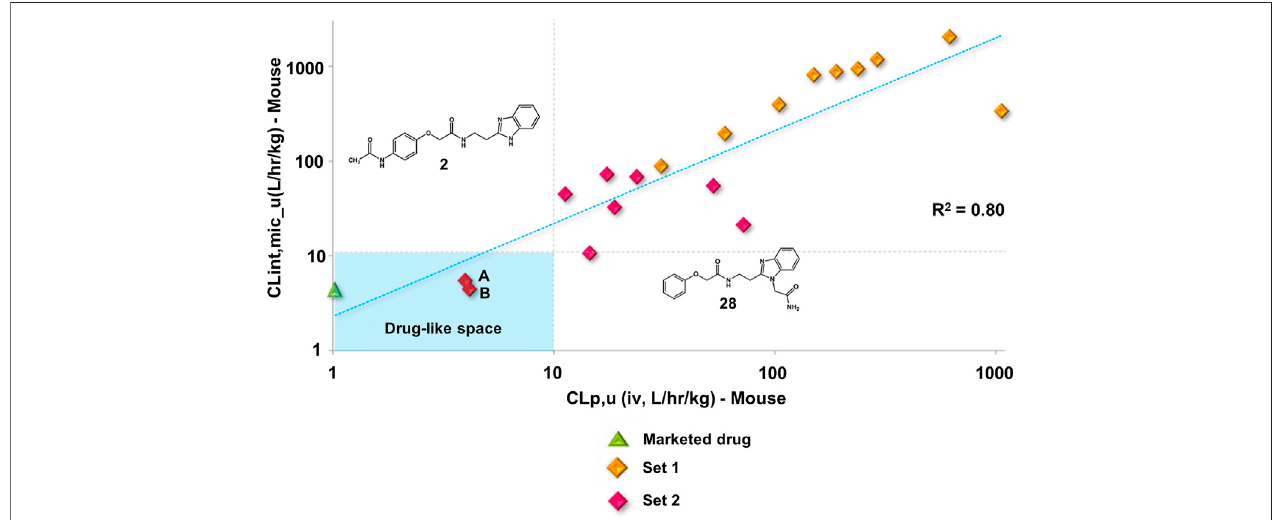
FIGURE 6 | Clearance in vitro-in vivo correlation (IVIVC) plot showing a good correlation between the metabolic stability data. Benznidazole (green triangle); set 1 compounds (orange diamonds); set 2 compounds (red diamonds). Compounds 2 (A) and 28 (B) .